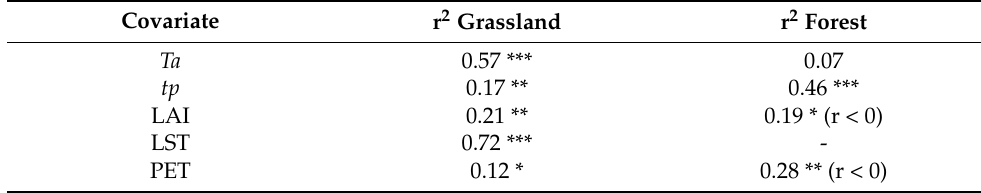
Table 4. Correlation between ET from flux tower observations and the covariates specified in the column “Covariate”. The correlation analysis was performed separately for grassland (AT-Neu, CH-Cha, CH-Fru, IT-MBo, IT-Tor) and forest (CH-Dav, IT-Lav, IT_Ren) sites. All the variables were aggregated during the growing